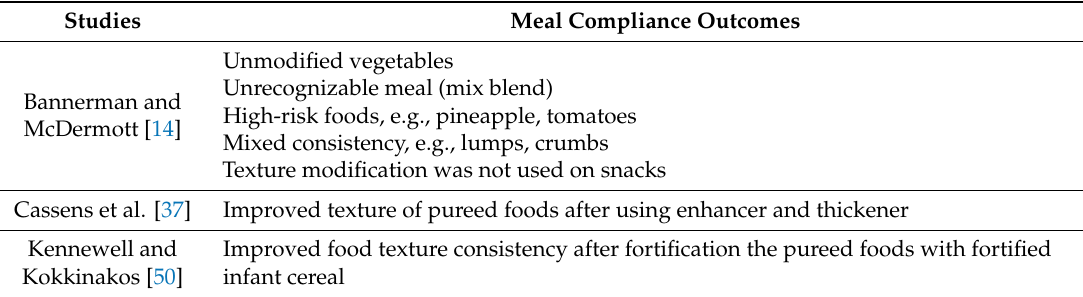
Table 3. Outcome data for studies assessing meal